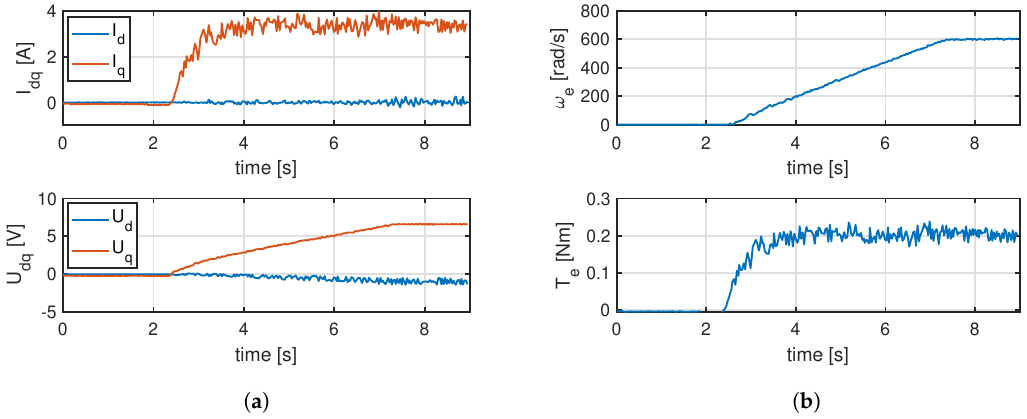
Figure 26. ( a ) dq currents and voltages; ( b ) ω e and T e during start-up sequence of Figure